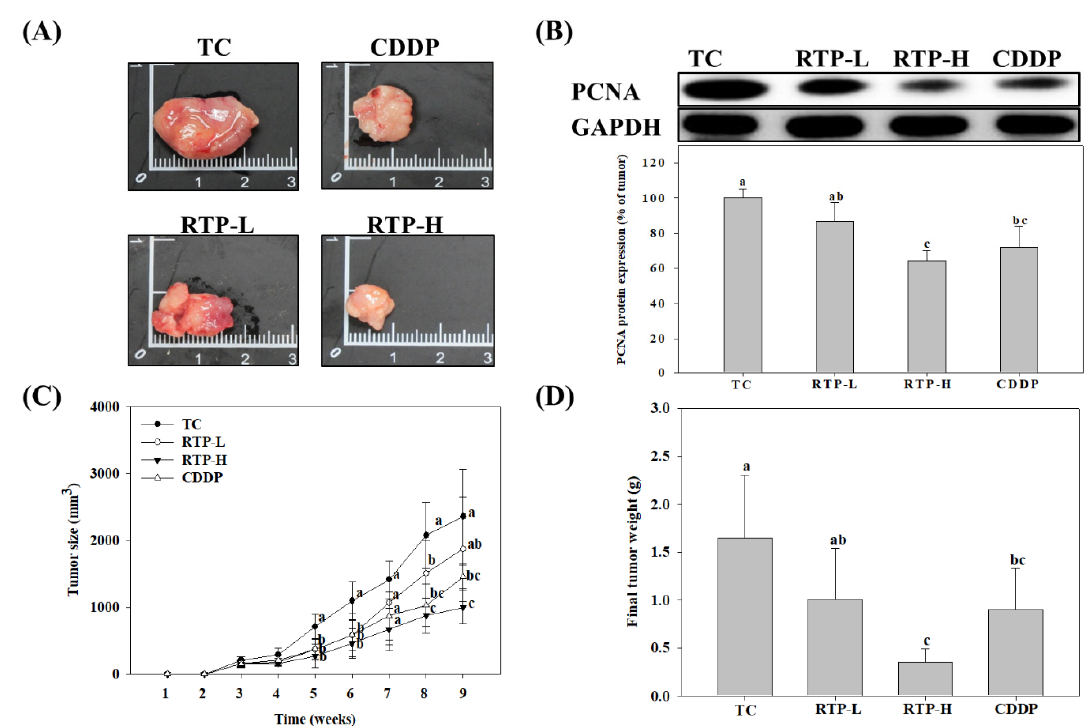
Figure 5. Effects of rutaecarpine (RTP) on ( A ) gross tumor tissue morphology and size; ( B ) protein expression of proliferating cell nuclear antigen (PCNA); ( C ) tumor size; and ( D ) tumor weight in tumor-bearing mice. Male tumor-bearing nude mice were treated with RTP or cisplatin (CDDP) as described in the Methods. The tumor control (TC) was administered the vehicle only. TC: tumor only; RTP-L: RTP by oral gavage at 25 mg/kg; RTP-H: RTP by oral gavage at 75 mg/kg; CDDP: intraperitoneally injected CDDP at 5 mg/kg. Values (means ± SD, n = 9) not sharing a common lower case letter are significantly different ( p < 0.05).